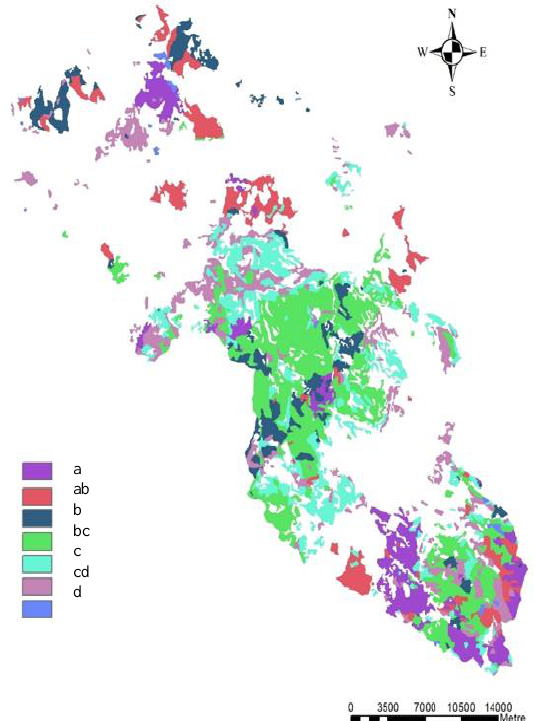
Figure 3 . The tree stage map.